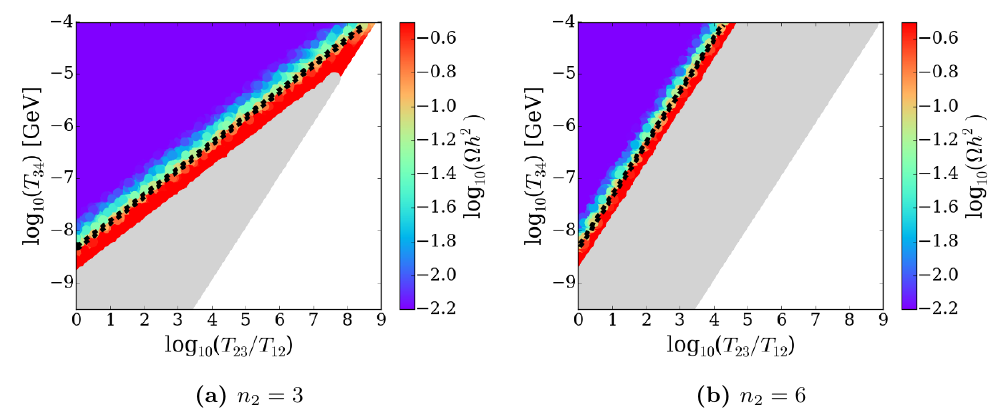
Figure 9. The value of log ((cid:10) h 2 ), colour-coded as indicated in the legend, in the T 34 , T 23 =T 12 10 parameter plane of the quintessence model. The accepted parameter sets lie between the two dashed lines, the grey region is excluded by BBN and the white one is not accessible in this